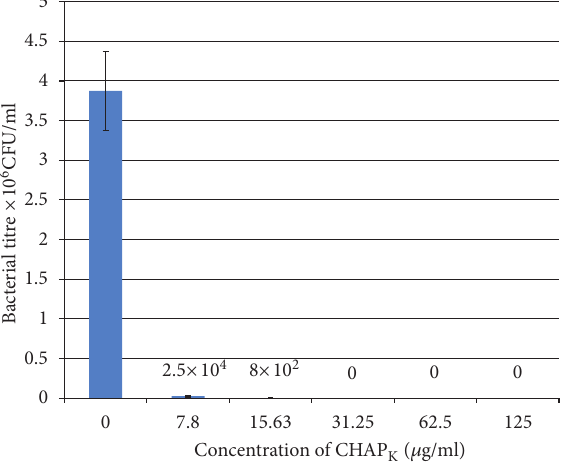
F 4: CHAP bio�lm prevention assay: viable plate count . K Concentrations of enzyme ranging from